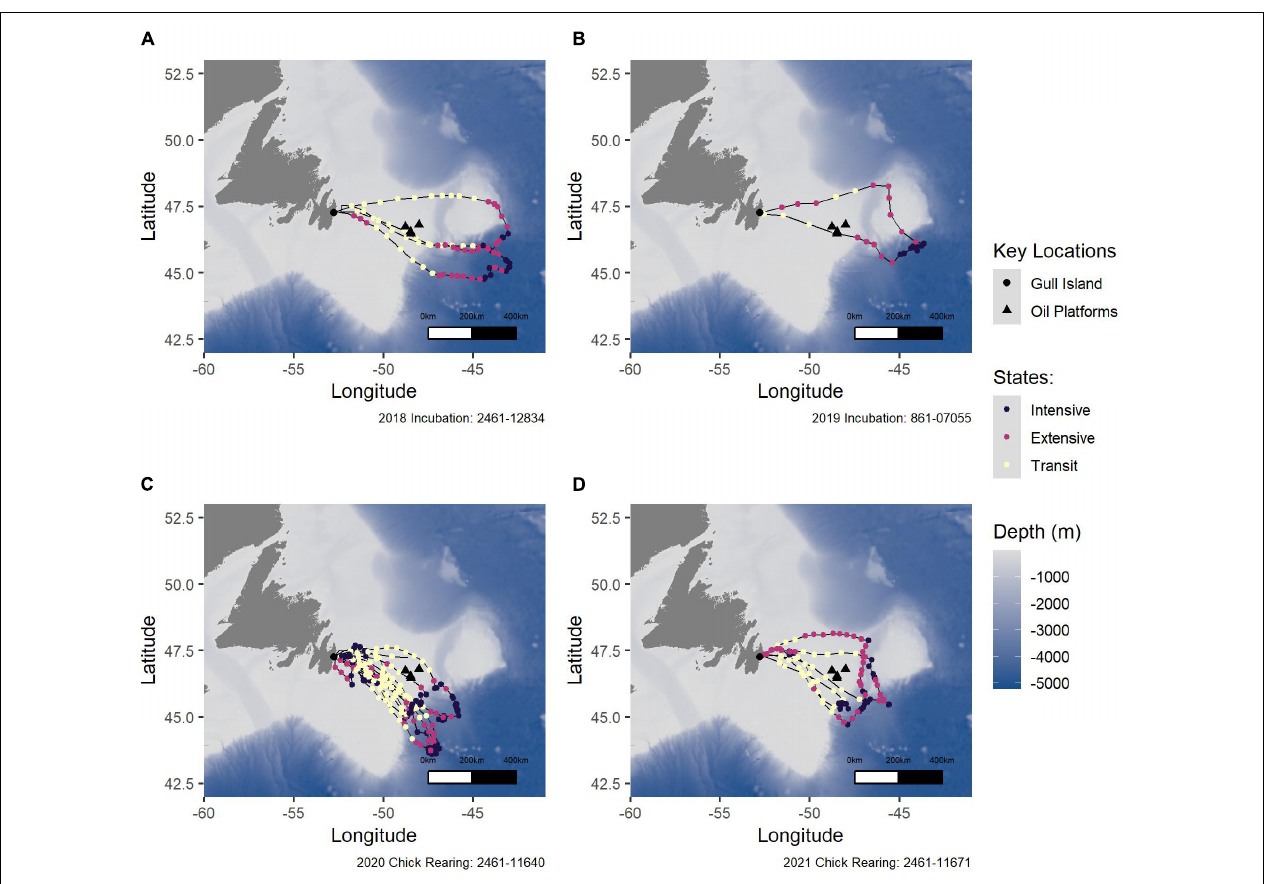
FIGURE 5 | A selection of tracks from individual Leach’s Storm-Petrels in the study sample from incubation in (A) 2018, (B) 2019, and from chick-rearing in (C) 2020, and (D) 2021. Black points represent intensive search, pink points represent extensive search, and yellow points represent transiting. The large black triangles represent the oil platforms, and the large black circle represents Gull Island. The bathymetry is represented where darker blue indicates deeper water. The 8- or 9-digit numbers indicate the ID of each bird.